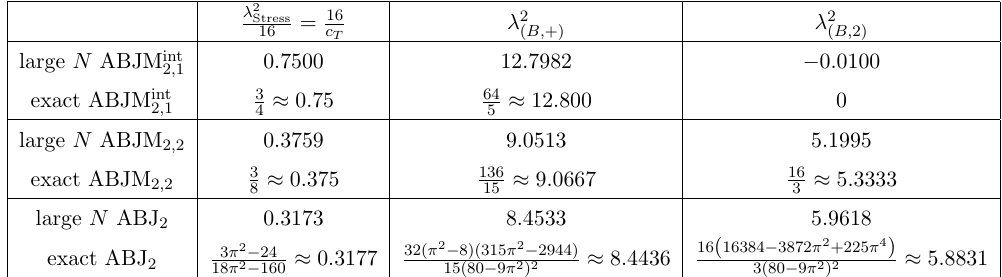
Table 5 . Comparison of the large N formulae to the exact values for N = 2 for OPE coe(cid:14)cients of 1 and 1 BPS operators that appear in O Stress (cid:2) O Stress for the interacting sector of ABJ(M). The 2 4 excellent agreement shows that the asymptotic formulas are reliable for all N (cid:21)